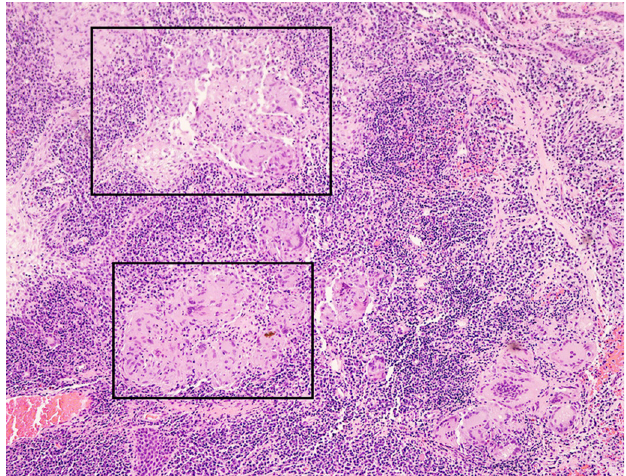
Fig. 6. Histological section of affected bone. Medium power reveals granulomatous in fl ammation consisting of tight aggregates of histiocytes and multinucleated giant cells in the background of diffuse plasma-lymphocytic in fi ltrate; hematoxylin-eosin, 100 (cid:1)